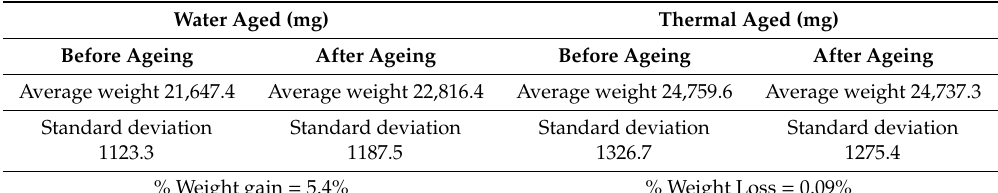
Table 1. Comparison of % weight change due to ageing.